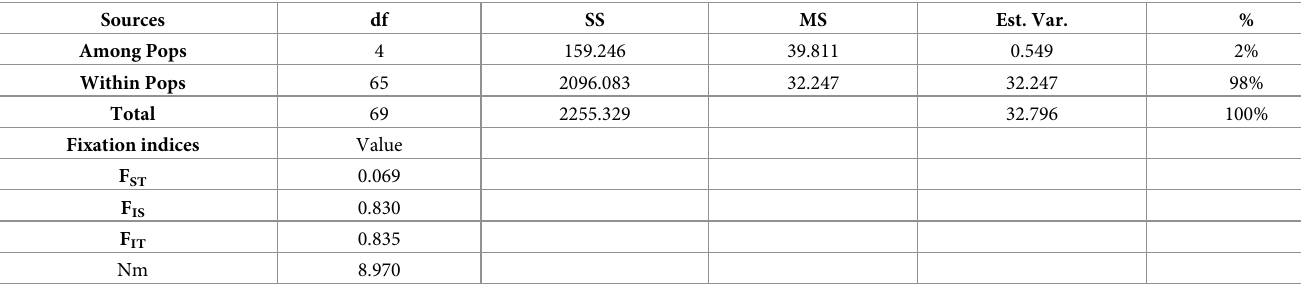
Population structure of the 70 cowpea accessions based on 28 SSR markers The structure analysis of the population structure based on the Δ K value grouped the seventy accessions into two subpopulations (clusters) (Fig 4A and 4B). Membership of all genotypes to a particular subpopulation was based on a likelihood threshold of 0.55. Subpopulation 1 had the largest membership with 64.28% of the accessions, while the smallest was Cluster 1 which only gathered 35.71% of the accessions (Table 8). Based on the threshold of 0.55, the study did not reveal any admixture among the accessions. Both subpopulations were composed of acces- sions from the five regions, and white-colored seeds dominated both. The first subpopulation comprised five accessions from the Centrale region, seven accessions from Kara region, nine accessions from Maritime region, 11 accessions from the Plateaux region and 13 accessions of the Savane region while subpopulation comprises five accessions from the Centrale region, fourth accessions from the Kara region, five accessions from the Maritime region, fourth accessions Plateaux region and 7 accessions of Savane region. Subpopulation 1 had more Table 7. Analysis of molecular variance (AMOVA) based on 28 SSR markers. Sources df Est. Var.